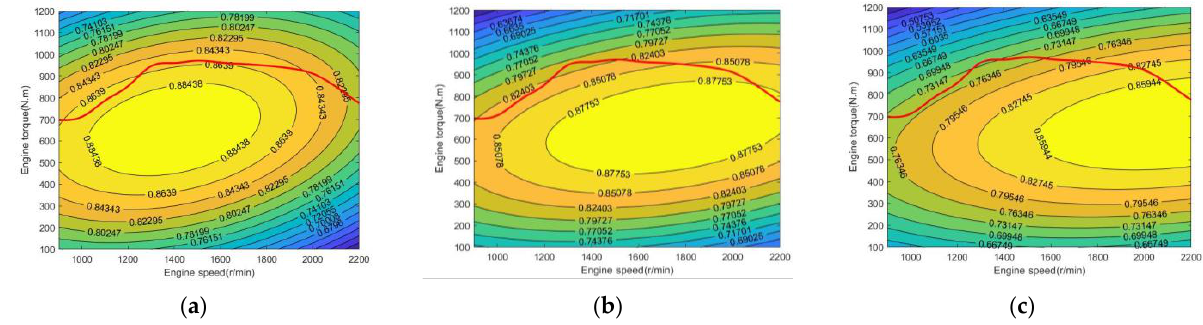
Figure 14. Efficiency characteristic field of HM1 at different speeds: ( a ) 4 km/h, ( b ) 6 km/h and ( c ) 7 km/h.